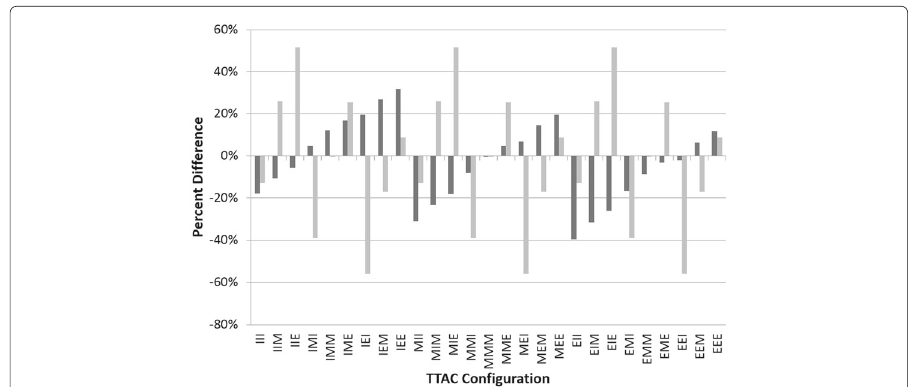
Fig. 2 Variation in K i due to respiration. The percentage difference between the true and measured K i 2 (dark grey bars) and K iP (light grey bars) in each of the different TTAC configurations where I, E and M represent ungated PET data reconstructed with an end inspiration, an end expiration and a mid-breathing cycle ‘snap shot’ CT for AC respectively (i.e. IEM = the early study section PET data were reconstructed with an end inspiration CT for AC, the mid section with an end expiration CT for AC and the late section with a mid-breathing cycle CT for